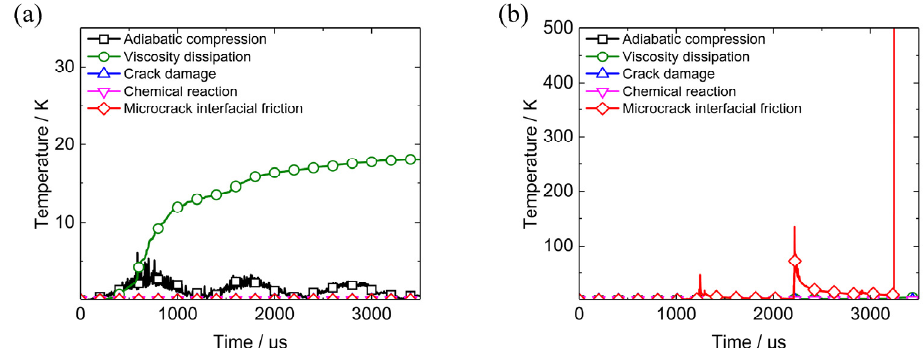
Figure 18. Temperature increases in Element A and B due to different heating mechanisms. ( a ) Element A, ( b ) Element B.